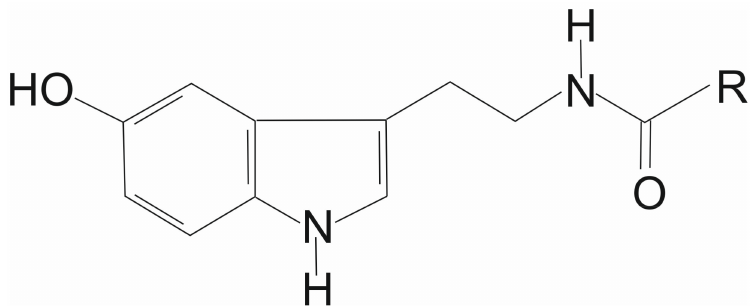
Figure 1. Chemical structure of N -acylserotonins. R—fatty acid